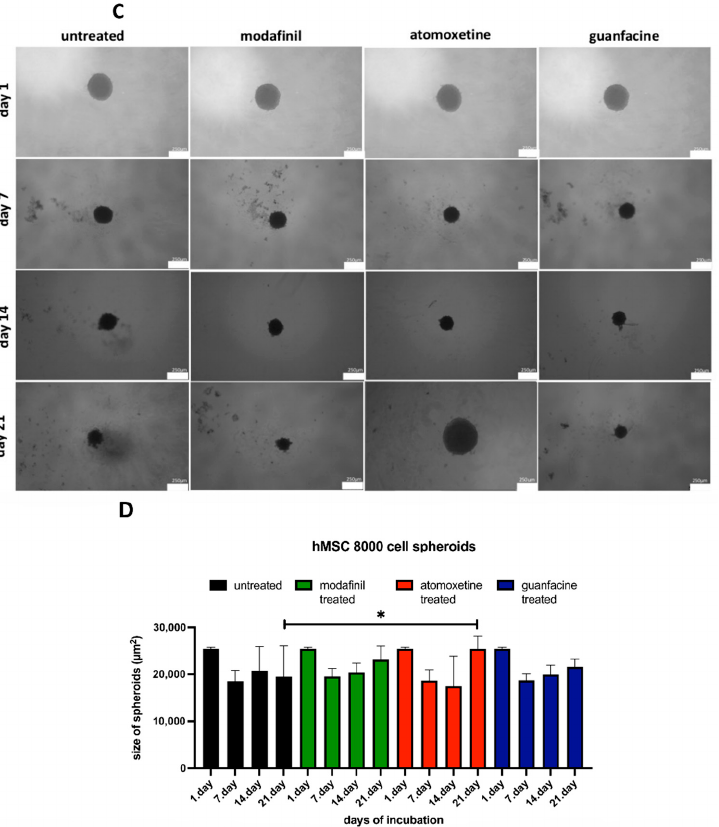
Figure 3. The effect of starting cell number under administration of untreated modafinil. (11.2 µg/mL), atomoxetine (0.9 µg/mL) and guanfacine (17.7 ng/mL) on spheroid size and morphology of hMSC (5000 cells) ( A , B ) and hMSC (8000 cells) ( C , D ). Spheroids were cultured for 21 days. Phase-contrast images of spheroids were taken at day 7, 14 and 21. Shown are means of spheroid size ± SD of three independent experiments with six biological replicates. Densitometric quantification of spheroid size was calculated by ImageJ software. Significance in difference between the groups was determined by ANOVA followed by Tukey’s post hoc test. Scale bar 250 µm. * corresponds to a value of p < 0.05 .